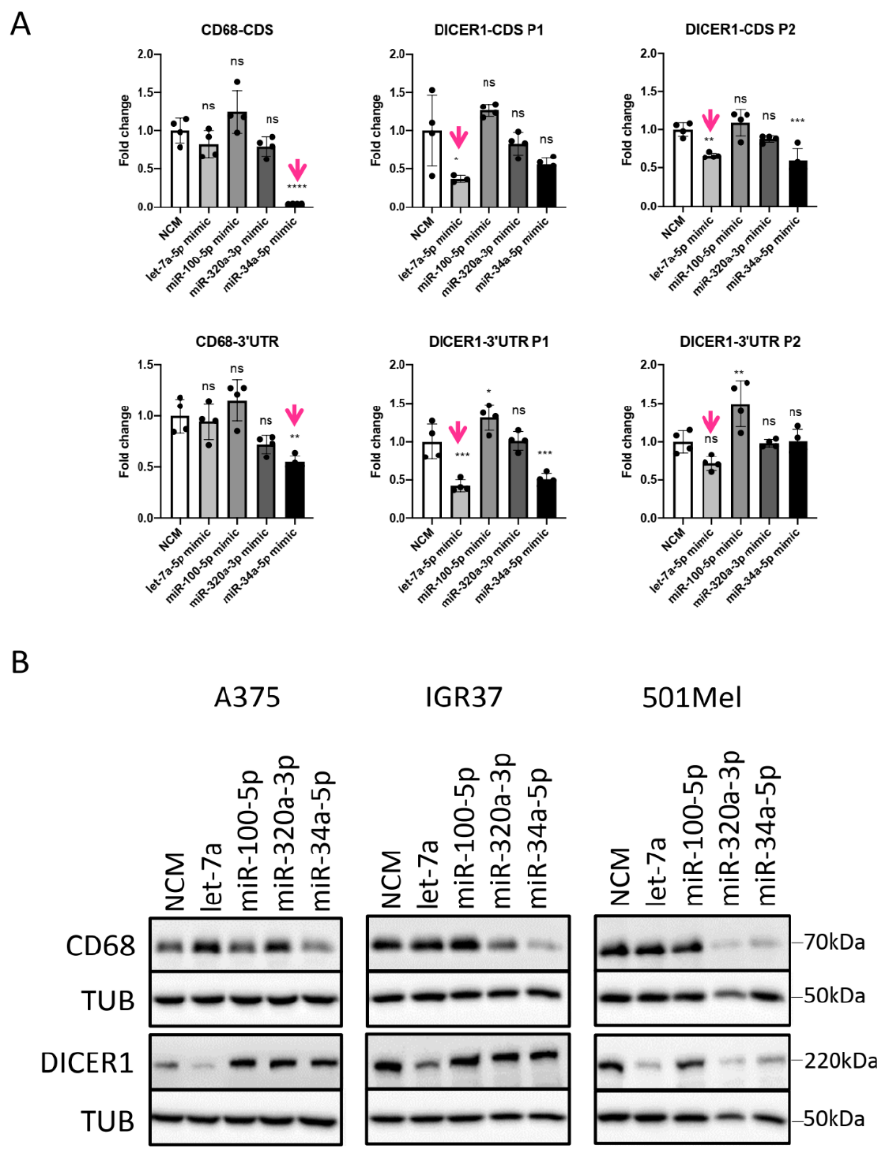
Figure 8. Experimental validation of miRNA–mRNA interactions. ( A ) Luciferase reporter vectors containing stretches of the target CDS or 3 ′ UTR for selected miRNAs were transfected into A375 cells together with 50 nM miRNA mimic or NCM for 72 h. Illustrated are the mean ± standard deviation (SD) of at least three replicates. Statistical significance was determined by one-way ANOVA, followed by Dunnett’s multiple comparisons test with ns, not significant; * p ≤ 0.05; ** p ≤ 0.01; *** p ≤ 0.001; **** p ≤ 0.0001. P1 and P2 represent the parts of the cloned region. ( B ) Protein expression levels of selected miRNA targets upon 50 nM miRNA mimic or NCM treatment for 72 h in three different melanoma cell lines.